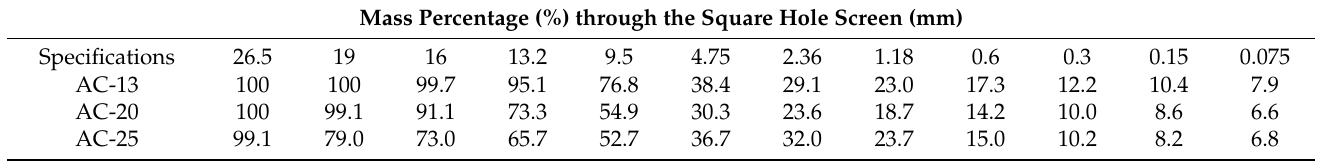
Table 2. Asphalt mixture selection